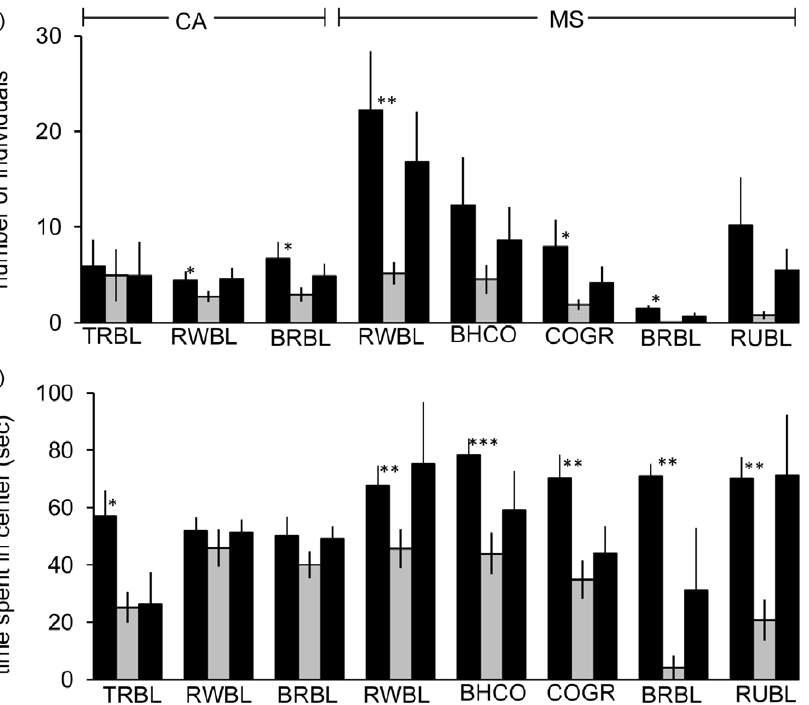
Figure 1. Neophobia reactions of the species under investigation. Means and standard errors of A) number of individuals per species in center and B) time spent in center are shown for the two control and the experimental trials. Stars indicate significant differences between control trial 1 and experimental trial (paired t-test). *: p # 0.05; **p # 0.01 Black bars: control trials, grey bars: experimental trial TRBL: Tricolored blackbird, RWBL: Red-winged-blackbird, BRBL: Brewer’s blackbird, BHCO: Brown-headed cowbird, COGR: Common grackle, RUBL: Rusty blackbird; CA: California; MS: Mississippi.